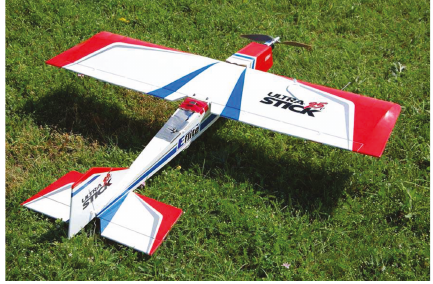
Figure 7: Ultrastick single-engine intruder.